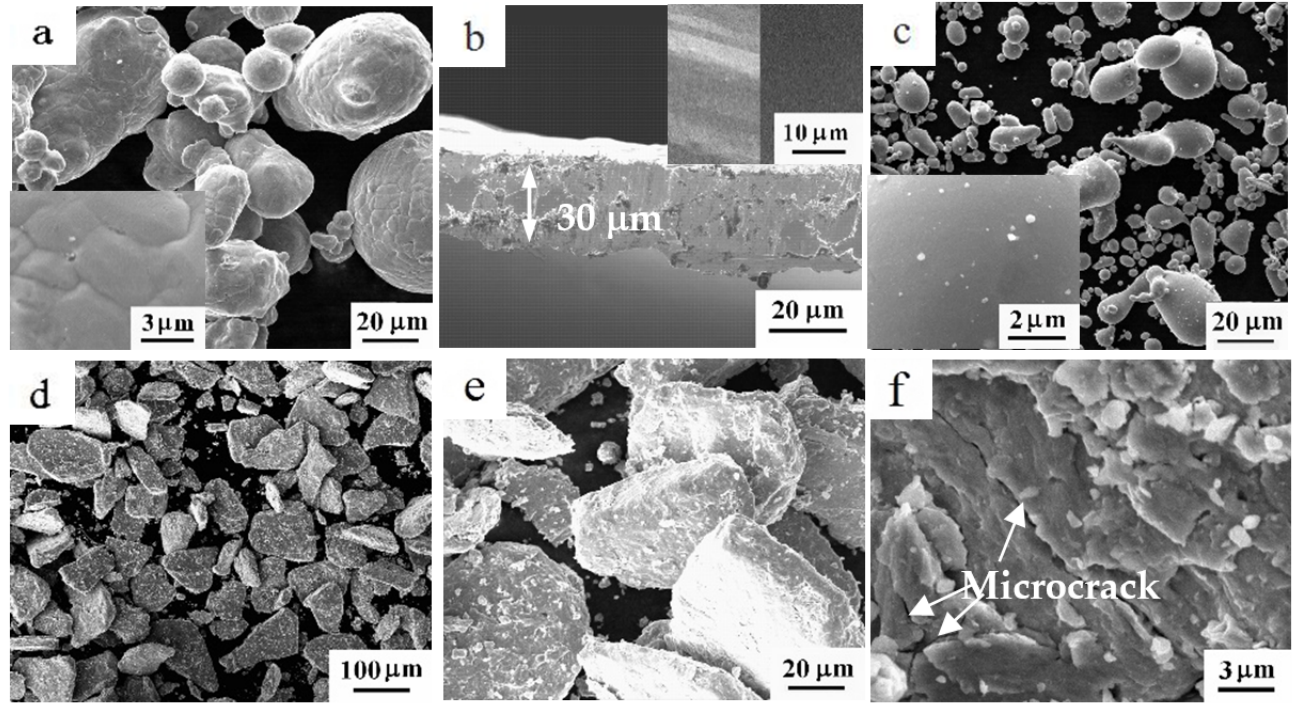
Figure 2. SEM images of the removal materials: ( a ) Fe CP , ( b ) FeSiB AR , ( c ) FeSiB AP , and ( d ) FeSiB BP . ( e ) and ( f ) are e nlarged images of the particles in ( d ). The insets highlight surface details ( e ) and ( f ) are enlarged images of the particles in ( d ). The insets highlight surface details of the of the materials.